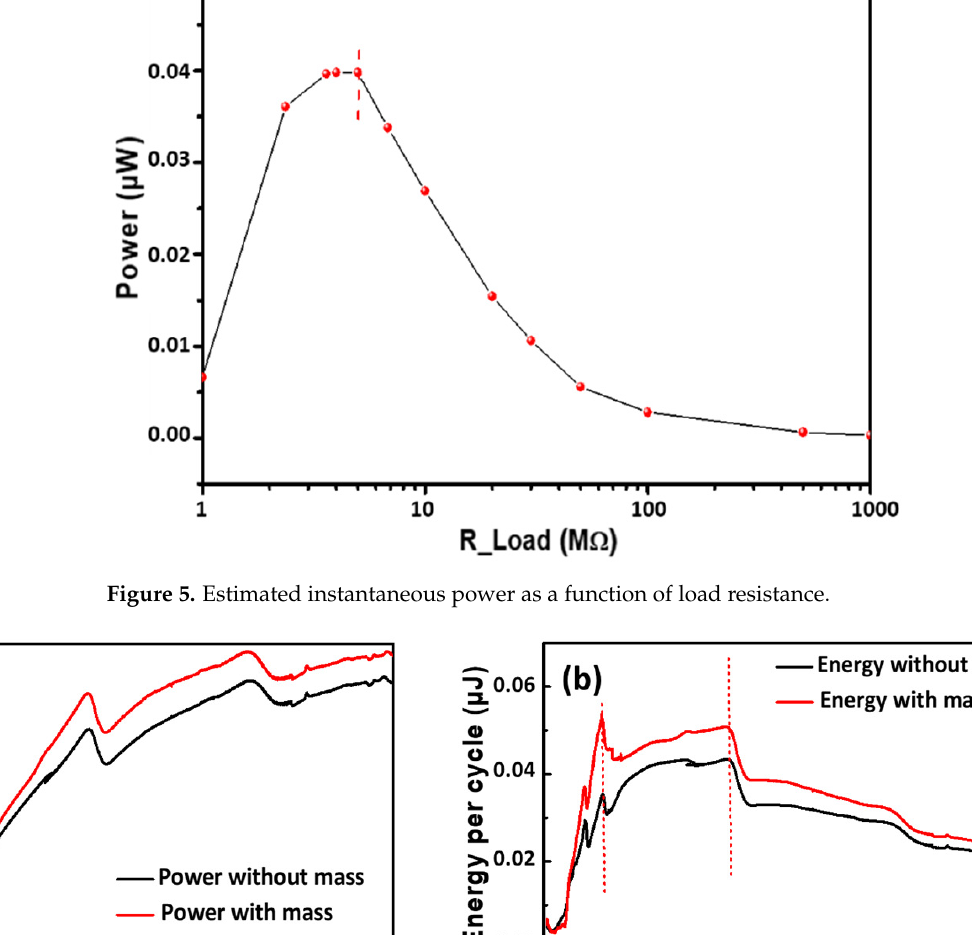
per cycle as function of vibrational frequency, with and without mass (2 g).